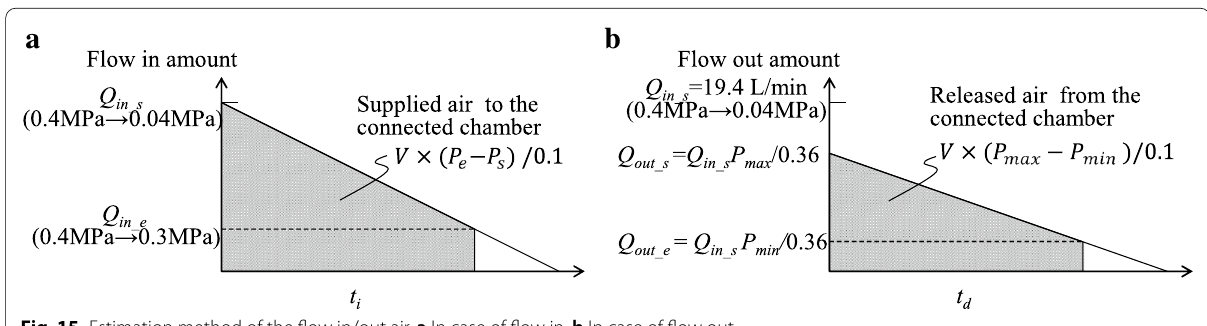
Fig. 15 Estimation method of the flow in/out air. a In case of flow in. b In case of flow